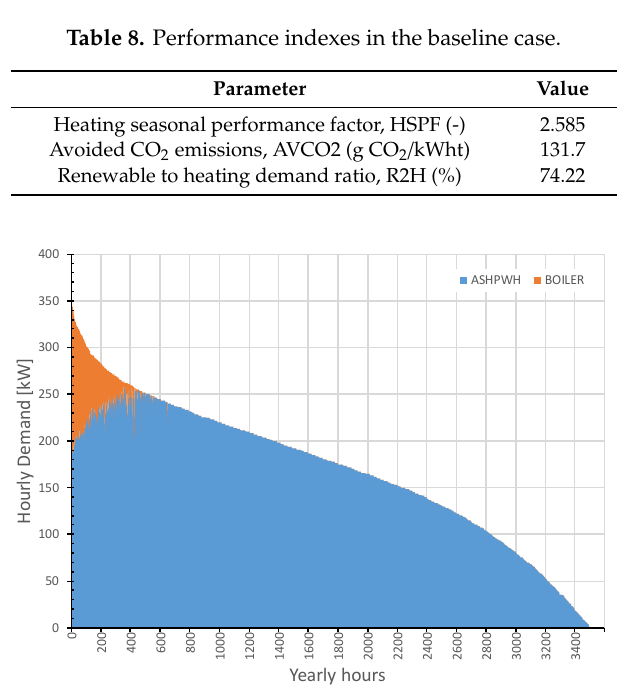
Figure 8. Contribution of heat pump (ASHPWH) and back-up boiler (BOILER) to meet the annual cumulative heating demand profile in the baseline case (block dwellings in Madrid built between 1981 to 2007 with 6000 m 2 of total heated surface).